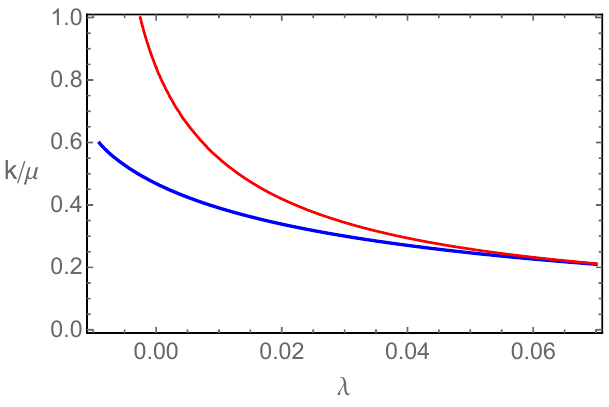
Figure 6 . The blue line is the lowest critical value of momentum as a function of (cid:21) (when (cid:11) ’ 0 : 213) at which the static solution appears. It corresponds to the lower boundary of the bell curve in (cid:12)gure 4 at zero temperature. The red line is the boundary of m 2 at which the BF bound is 1 (cid:0)